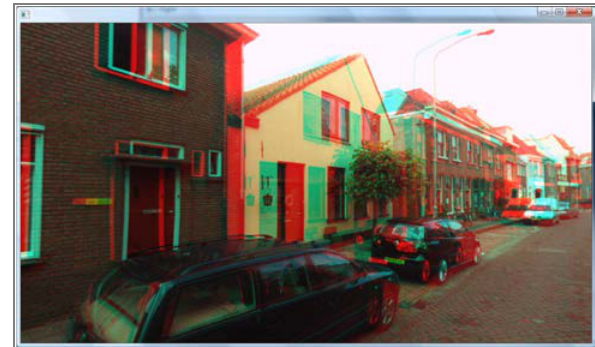
Figure 13. Stereo viewing using anaglyph